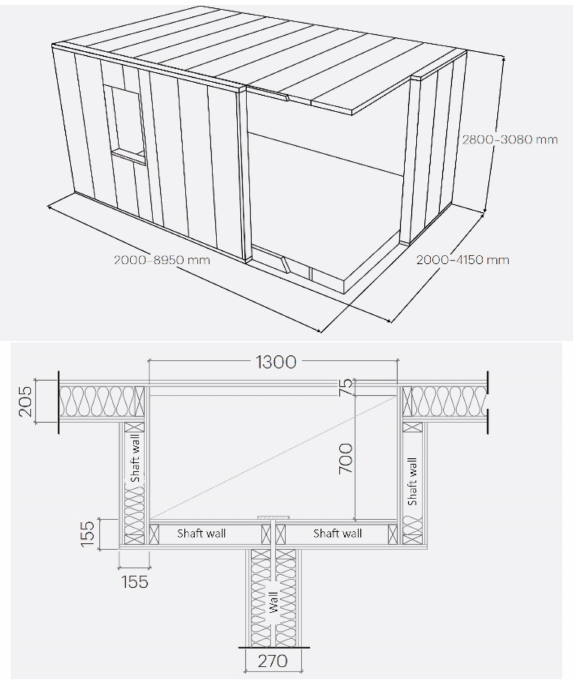
Figure 1. Examples of constraints in platform–based building systems (volume module and shaft geometry). (Figure courtesy of Lindbäcks